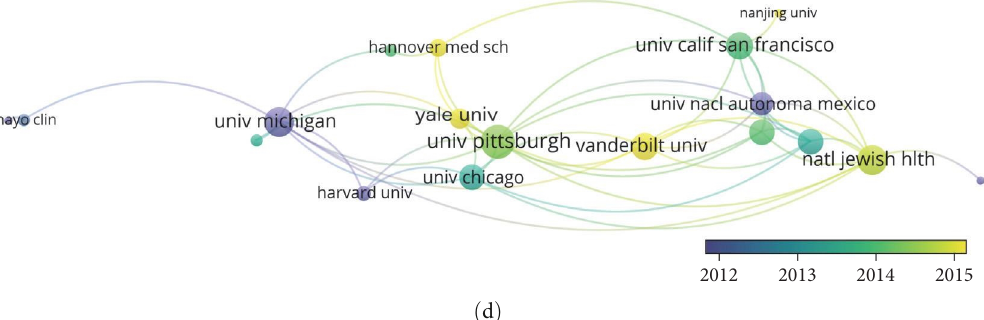
F IGURE 4: Contributions of different institutions in the fi eld of IPF and immune response. (a) The top 20 institutions ranked by the number of publications. The X -axis represents the percentage of the number of publications by the institution to the total. (b) Map of the international cooperation network of the top 20 institutions with at least eight publications in IPF and immune response. The circle size, the complexity of the network structure, and the thickness of the lines represents the importance in this fi eld. (c) Density visualization of institutional weight in this fi eld. (d) Institutions were colored based on the average publication time. Blue color represents published in the early years, and yellow color represents published more